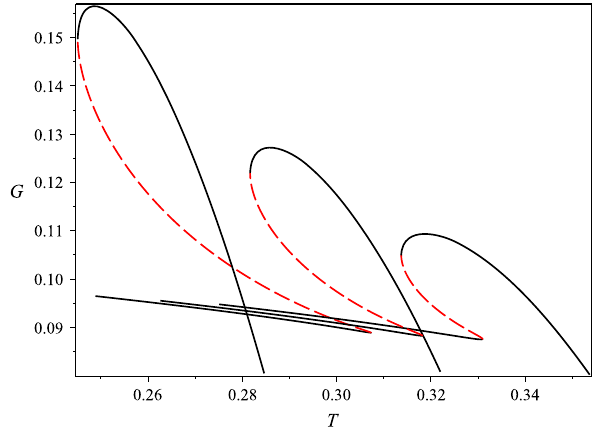
Fig. 7 Gibbsfreeenergyasafunctionoftemperatureforseveralvalues of pressure for n = 3, α = 0 . 5, b = 1, q = 0 . 1 which demonstrates instability region. Instability domains are represented by red dashed parts of the